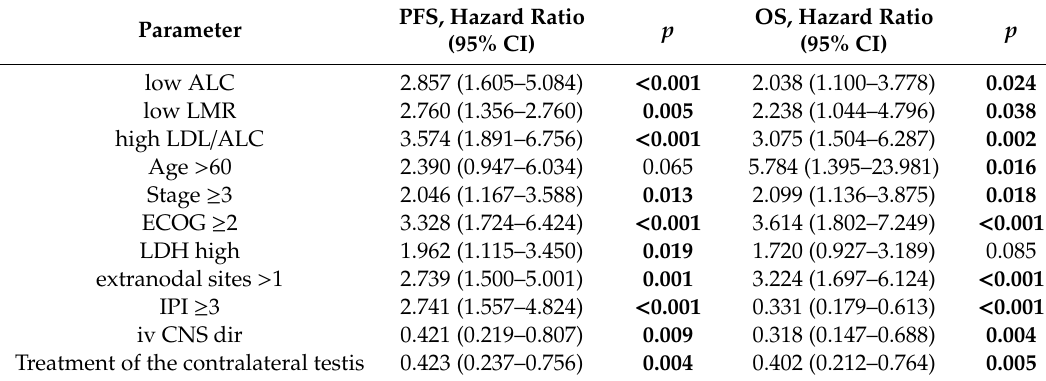
Table 2. Cox regression analyses on the univariate level of rituximab treated patients showing the association of baseline characteristics and treatment parameters with the